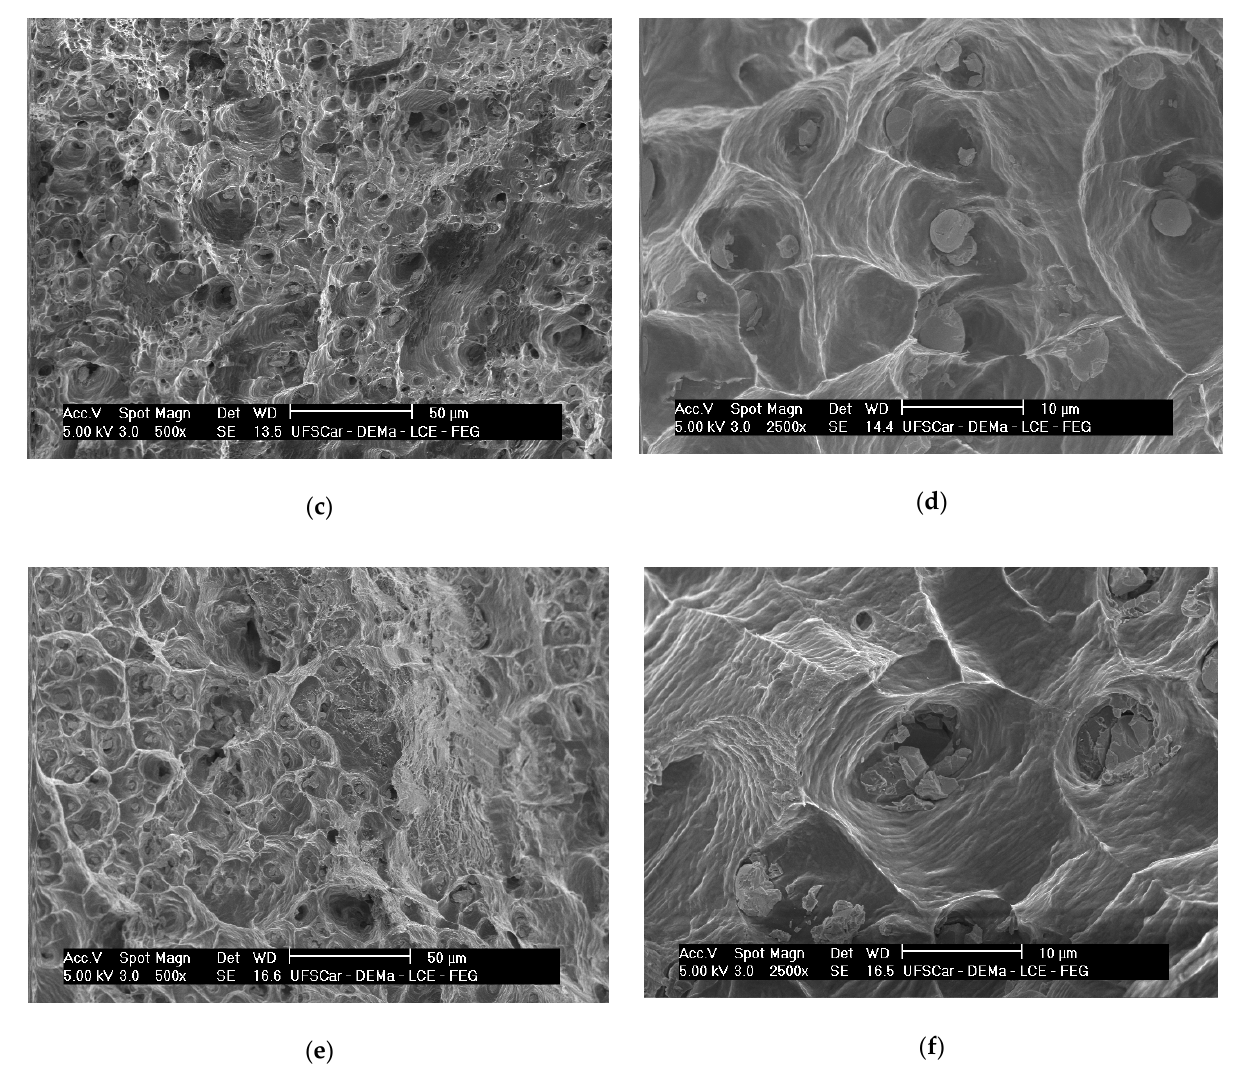
Figure 12. Fracture surfaces of the tensile-tested samples in two different magnifications: ( a , b ) Al-3.2 wt.% Bi, ( c , d ) Al-3.2 wt.% Bi-3.0 wt.% Zn, and ( e , f ) Al-3.2 wt.% Bi-3.0 wt.% Cu alloys.